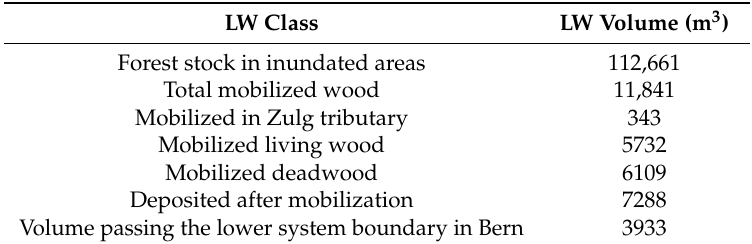
Table 1. Modelled solid LW volumes during an extreme flood in the Aare